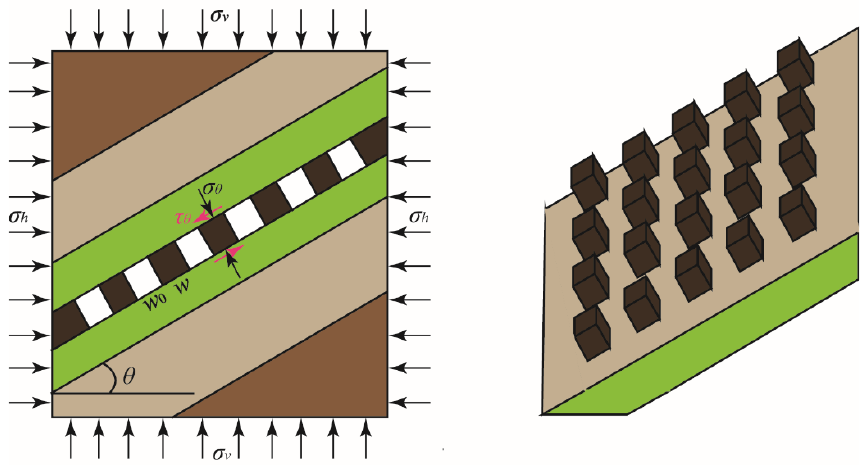
Figure 2. Sketch of force acting on the inclined layered ore-body and pillar.